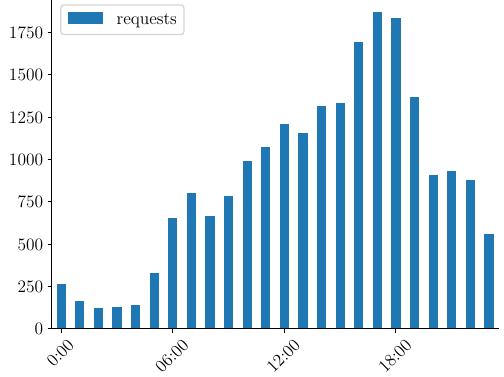
Figure 1. Hourly request throughout the day.